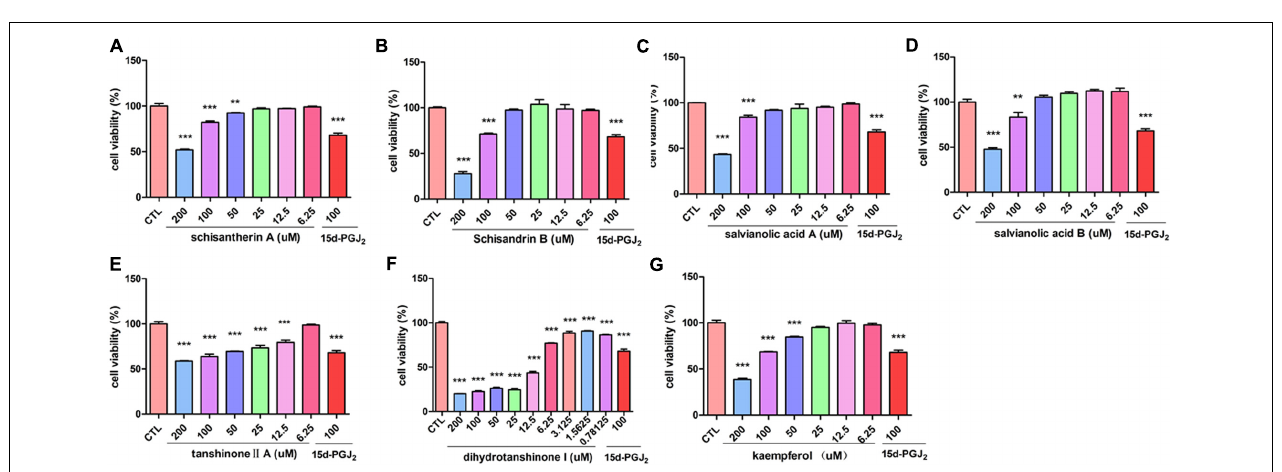
FIGURE 5 | Compound-Target protein-Differential gene protein network. This network was built by linking 28 active components (blue rectangles) in FZHY formula, 31 target proteins (purple ellipses) and 122 different gene proteins (pink ellipses).